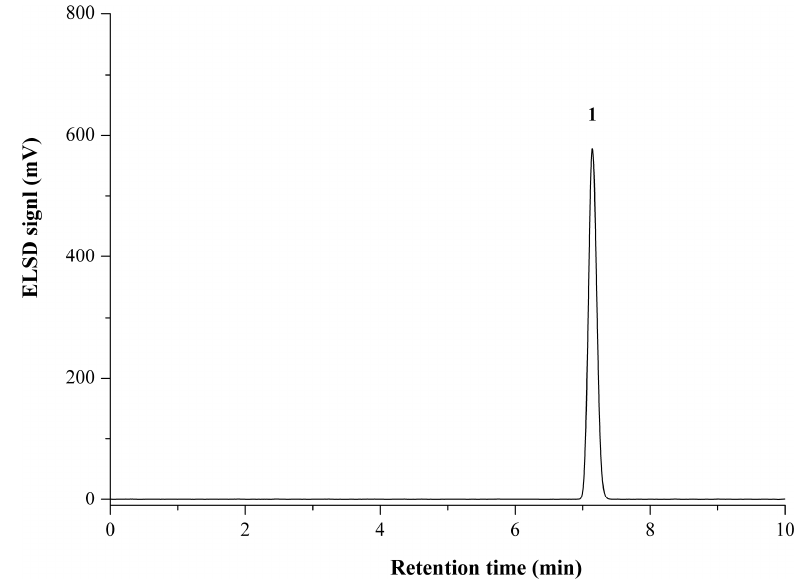
Figure 2. Typical high-performance liquid chromatography with evaporative light scattering detector (HPLC-ELSD) chromatogram of propionylbrassinolide standard on an Eclipse XDB-C 18 column (250 mm × 4.6 mm, 5.0 μ m) column.